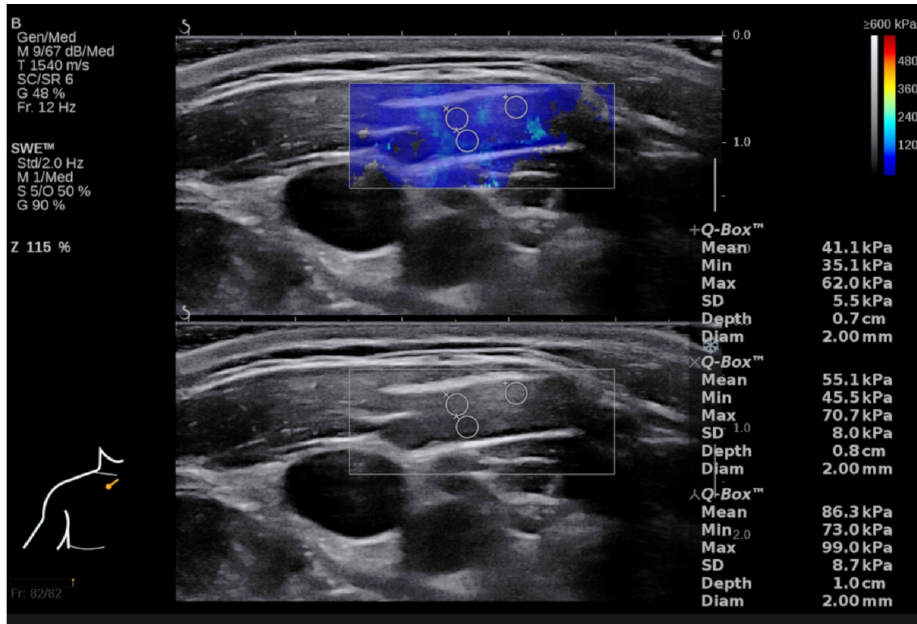
Fig. 1. Measuring stiffness of the sternocleidomastoid muscle with a linear probe in a patient with cervicogenic headache; the image depicts three ROIs at one of the four levels measured.